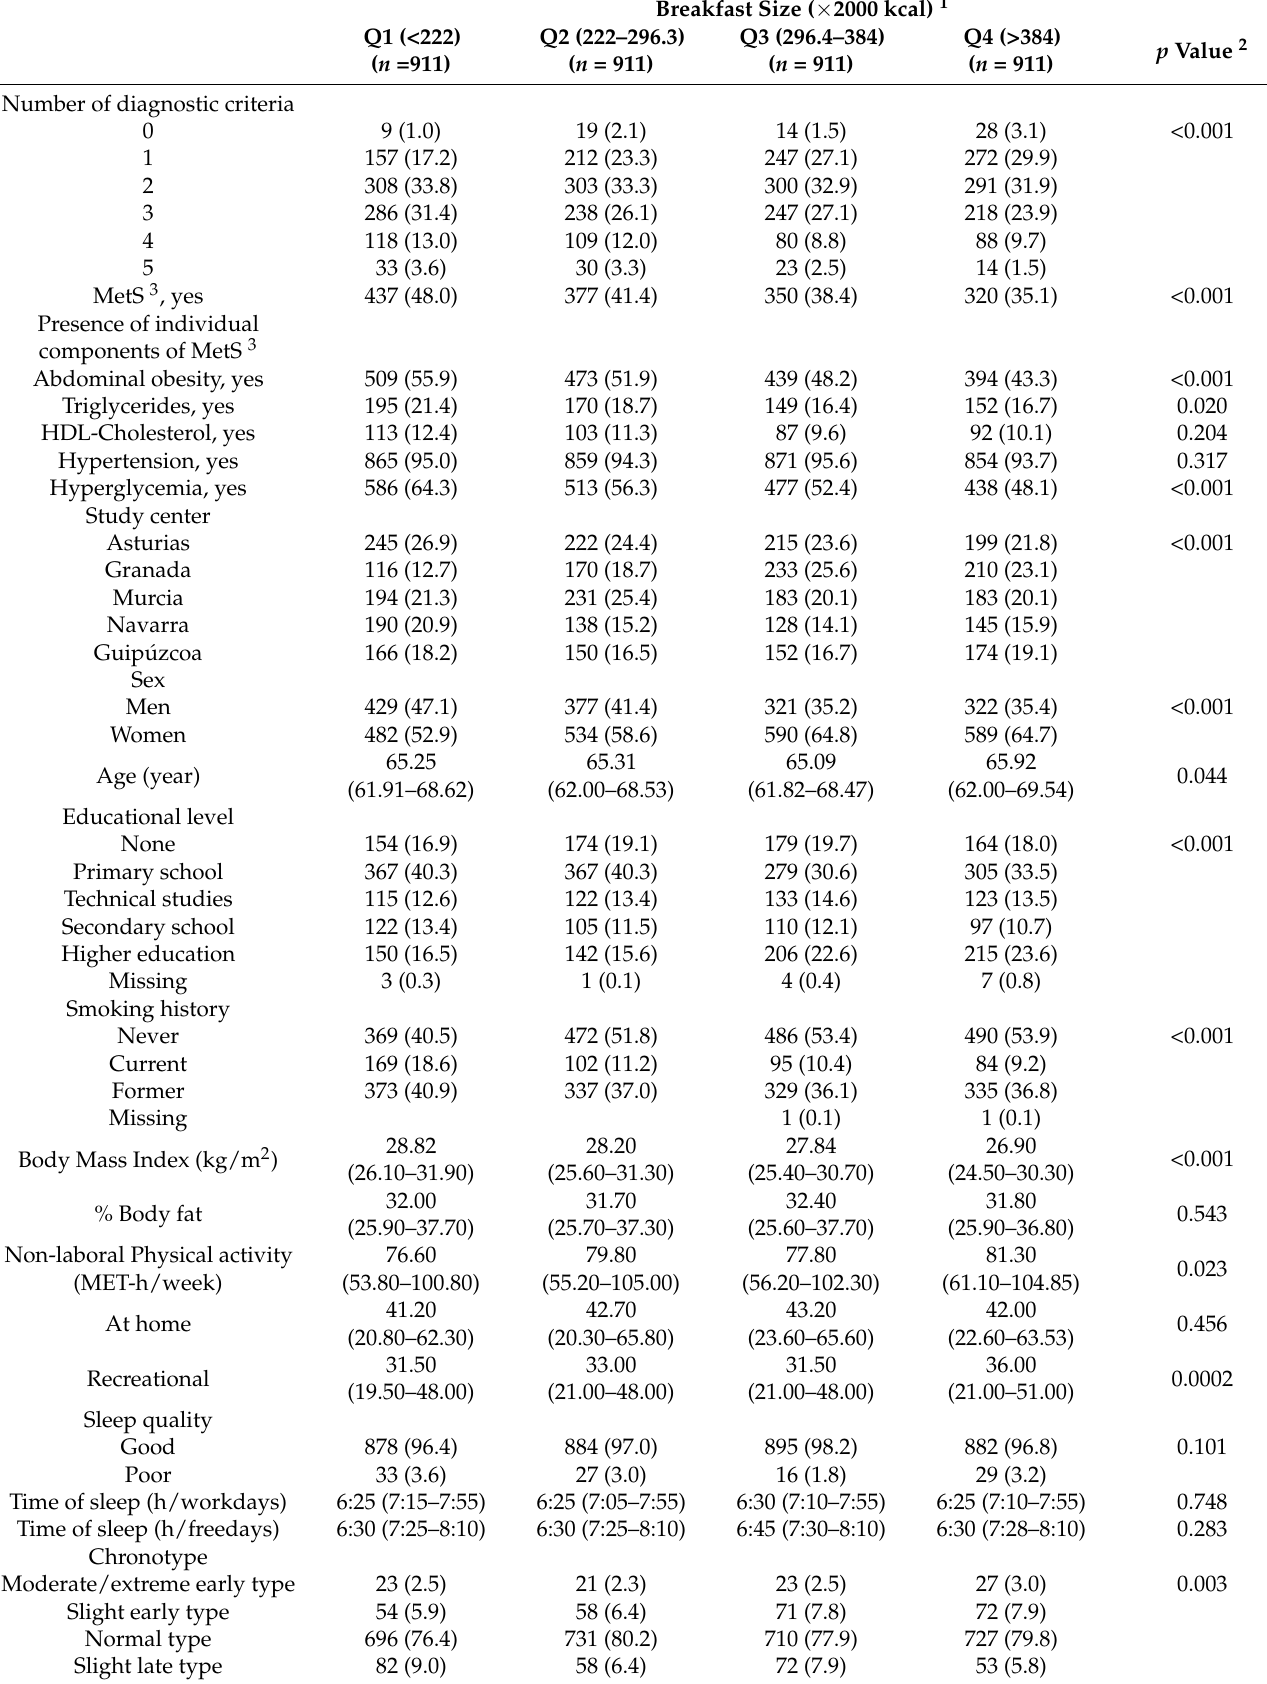
Table 2. Descriptive characteristics by quartiles of breakfast size ( × 2000